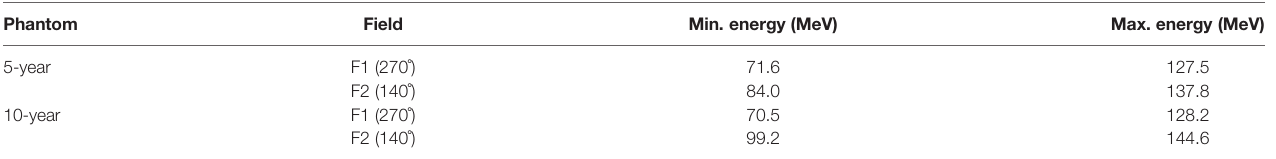
TABLE 1 | IMPT plans parameters for 5- and 10-year-old phantoms. Phantom